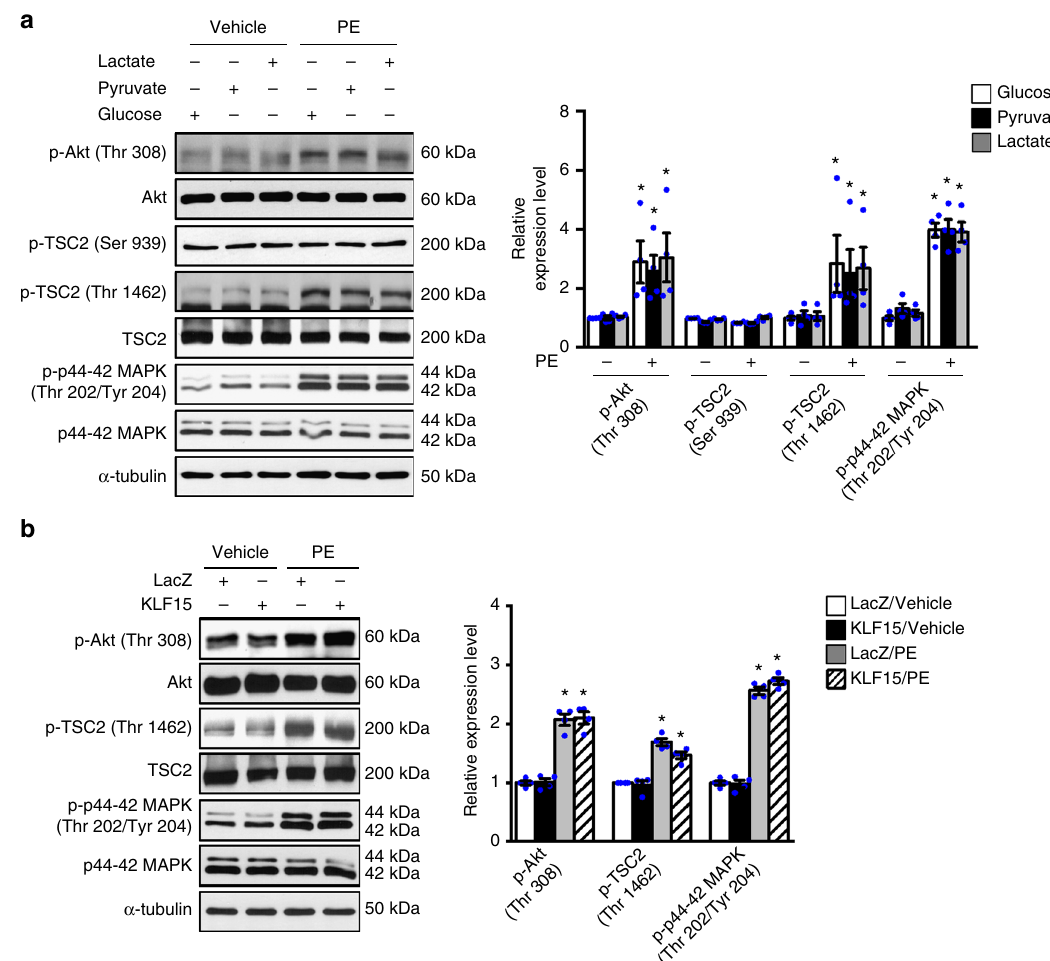
Fig. 7 Glucose does not affect signaling upstream of mTOR. a NRCMs incubated with DMEM medium containing glucose or non-glucose substrates were treated with phenylephrine (PE, 100 μ M) or vehicle for 6 h. Immunoblots of whole cell lysates (left) and statistical analyses of densitomeric measurements of p-Akt (Thr 308), p-TSC2 (Ser 939), p-TSC2 (Thr 1462), and p-p44 – 42 MAPK (Thr 202/Tyr 204) (right) are shown (* p < 0.05 vs. Glucose/PE( − ), n = 4). b NRCMs transduced with indicated adenovirus were treated with phenylephrine (PE, 100 μ M) or vehicle for 6 h. Immunoblots of whole cell lysates (left) and statistical analyses of densitomeric measurements of p-Akt (Thr 308), p-TSC2 (Thr 1462), and p-p44 – 42 MAPK (Thr 202/Tyr 204) (right) are shown (* p < 0.05 vs. LacZ/Vehicle, n = 4). Data shown as mean ± s.e.m. P values were determined using one-way ANOVA followed by Newman –